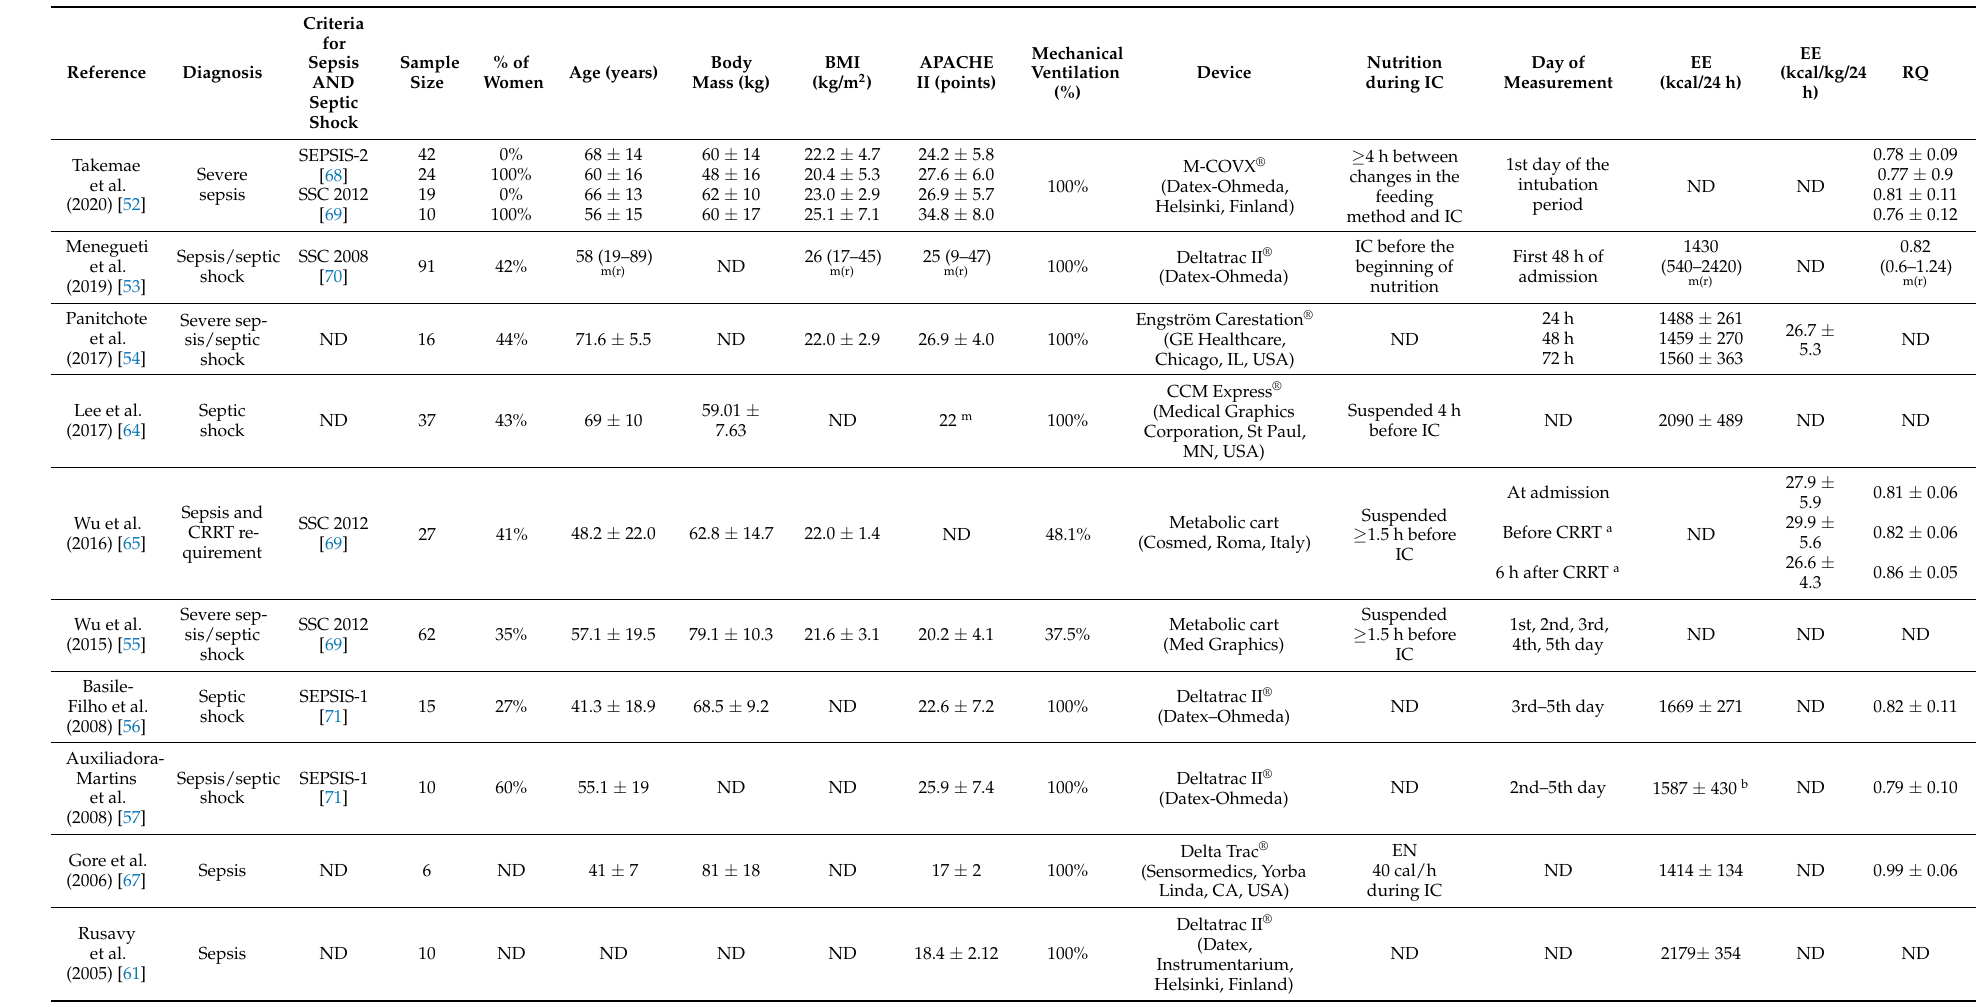
Table 2. Comparison of results and some aspects of the methodology in studies using indirect calorimetry in patients with sepsis or septic